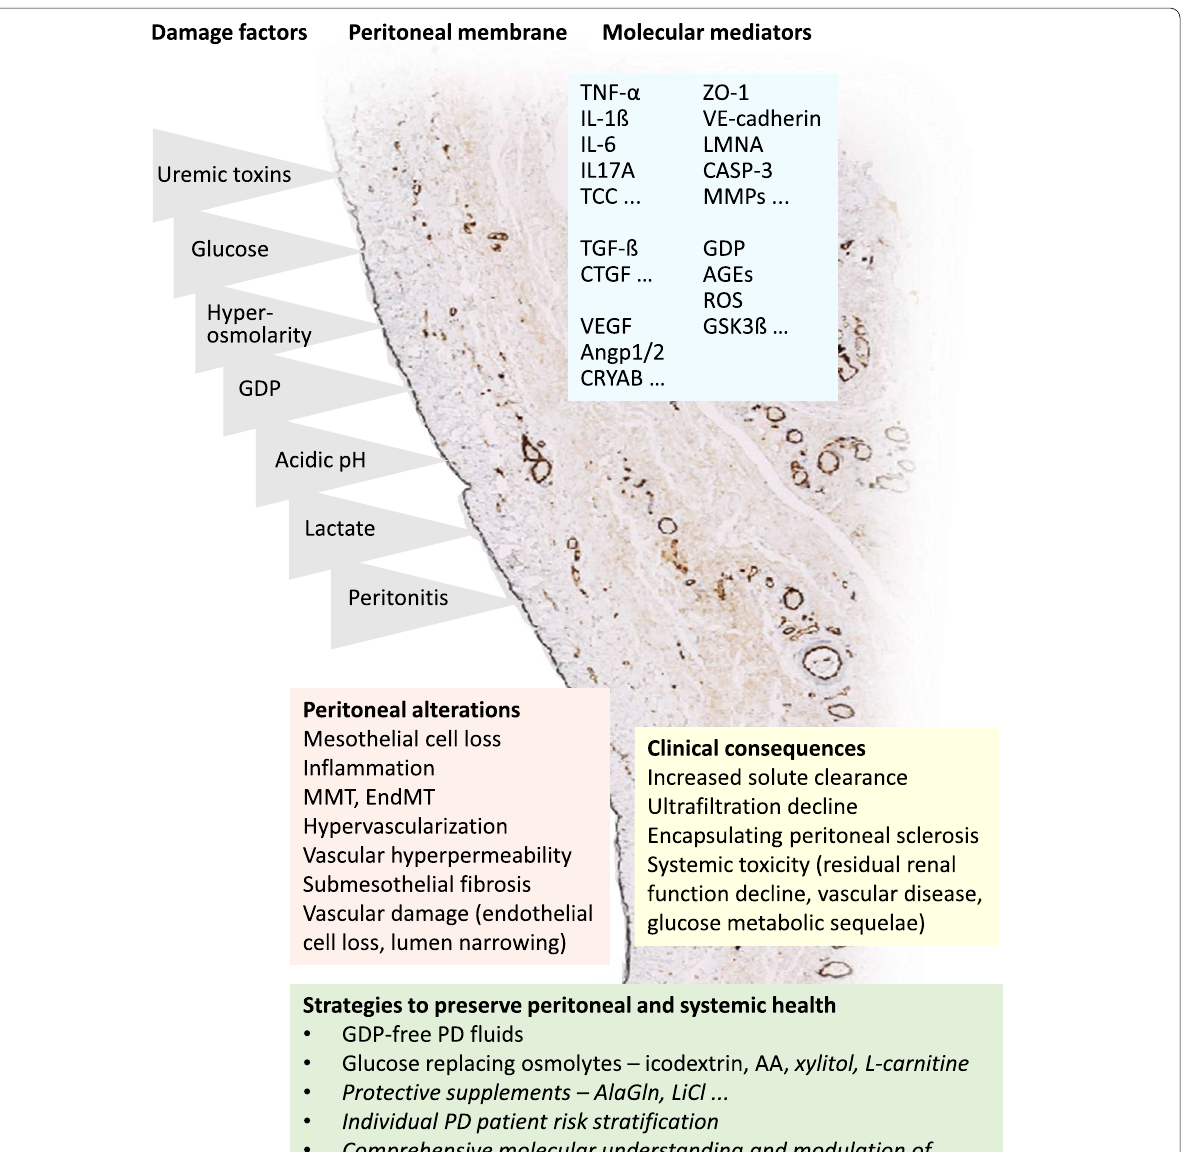
Fig. 1 Peritoneal dialysis associated local and systemic damage and protective strategies. Reactive metabolites accumulating with chronic kidney disease combined with the unphysiological composition of current PD fluids exert major local peritoneal and systemic damage, which compromise PD long-term function and contribute to accelerated patient aging. Strategies to mitigate these PD-related sequelae are given in the lower box; in italic strategies currently under development. AA, amino acids; AGEs, advanced glycation endproducts; AlaGln, alanyl-glutamine; Angp1/2, angiopoietin 1/2; CASP-3, caspase; CRYAB, crystallin alpha B; CTGF, connective tissue growth factor; EndMT, endothelial-mesenchymal transition; GDP, glucose degradation products; GSK3ß, glycogen synthase kinase-3 beta; IL, interleukin; LiCl, lithium chloride; LMNA, lamin A; MMPs, metalloproteinases; MMT, mesothelial-mesenchymal transition; ROS, reactive oxygen species; TCC, terminal complement complex; TGF-ß, transforming growth factor ß; TNF-α, tumor necrosis factor α; VE-cadherin, vascular endothelial cadherin; VEGF, vascular endothelial growth